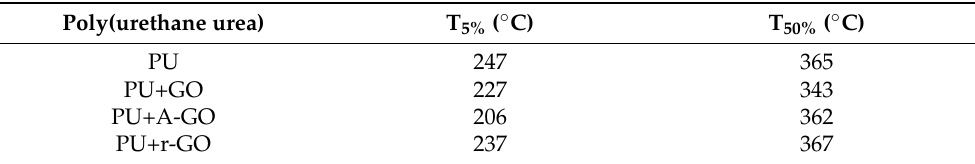
Figure 13. Variation of ( a ) the weight and ( b ) the derivative of the weight of the PUs as a function of the temperature. TGA experiment. Table 8. Values of the temperatures at which 5 (T 5% ) and 50 (T 50% ) wt.% are lost in the PUs. TGA experiments.